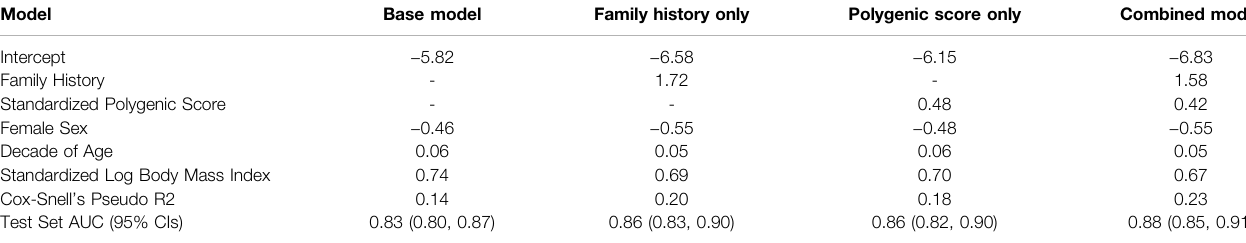
TABLE 3 | Logistic regression between prevalent T2D, family history, and the PGS in the Hispanic/Latino replication sample.